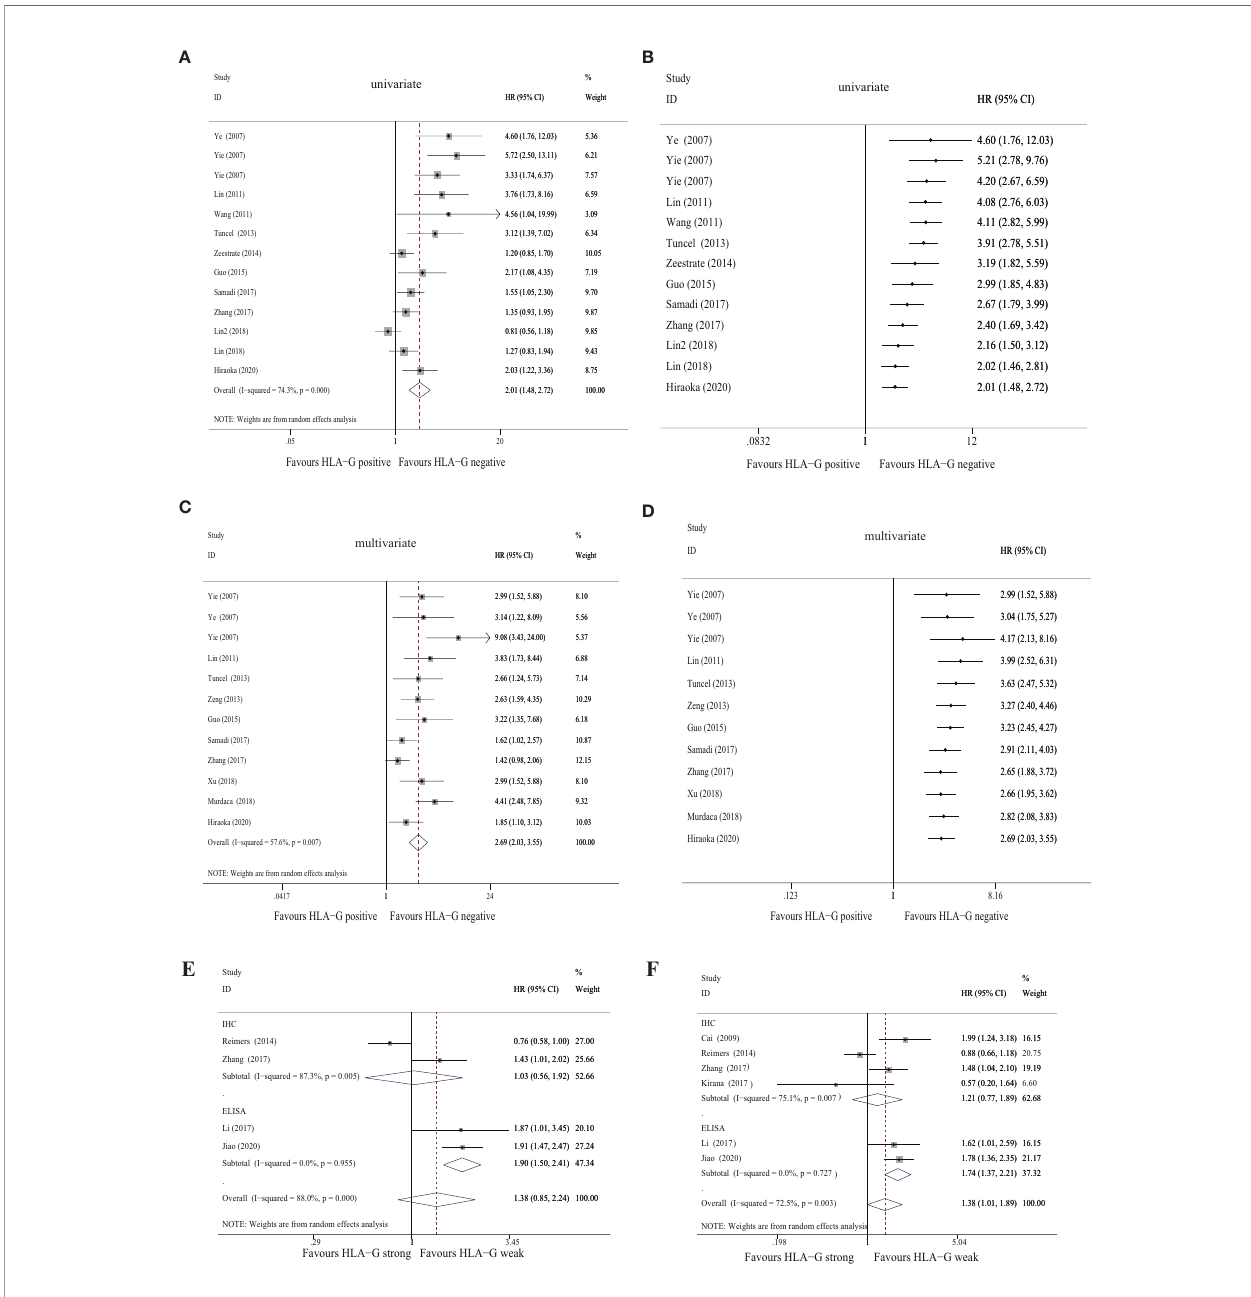
FIGURE 2 | Forest plot of primary outcomes in the studies in the meta-analysis and cumulative